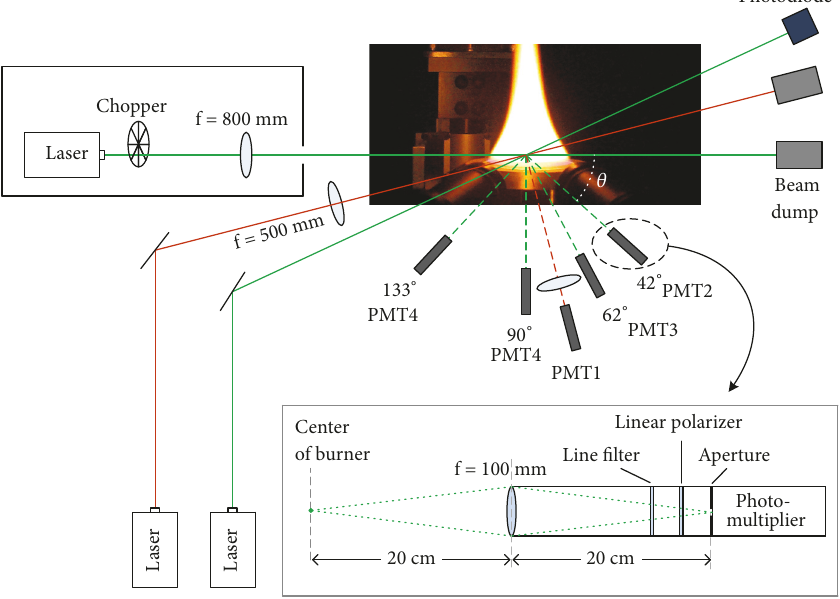
Figure 2: Schematic for the LII, extinction, and ADLS experimental setup. The LII signal is collected by photomultiplier PMT1. Angular orientations of the collection systems PMT2–PMT5 for ADLS measurements are denoted with respect to the forward direction of the laser